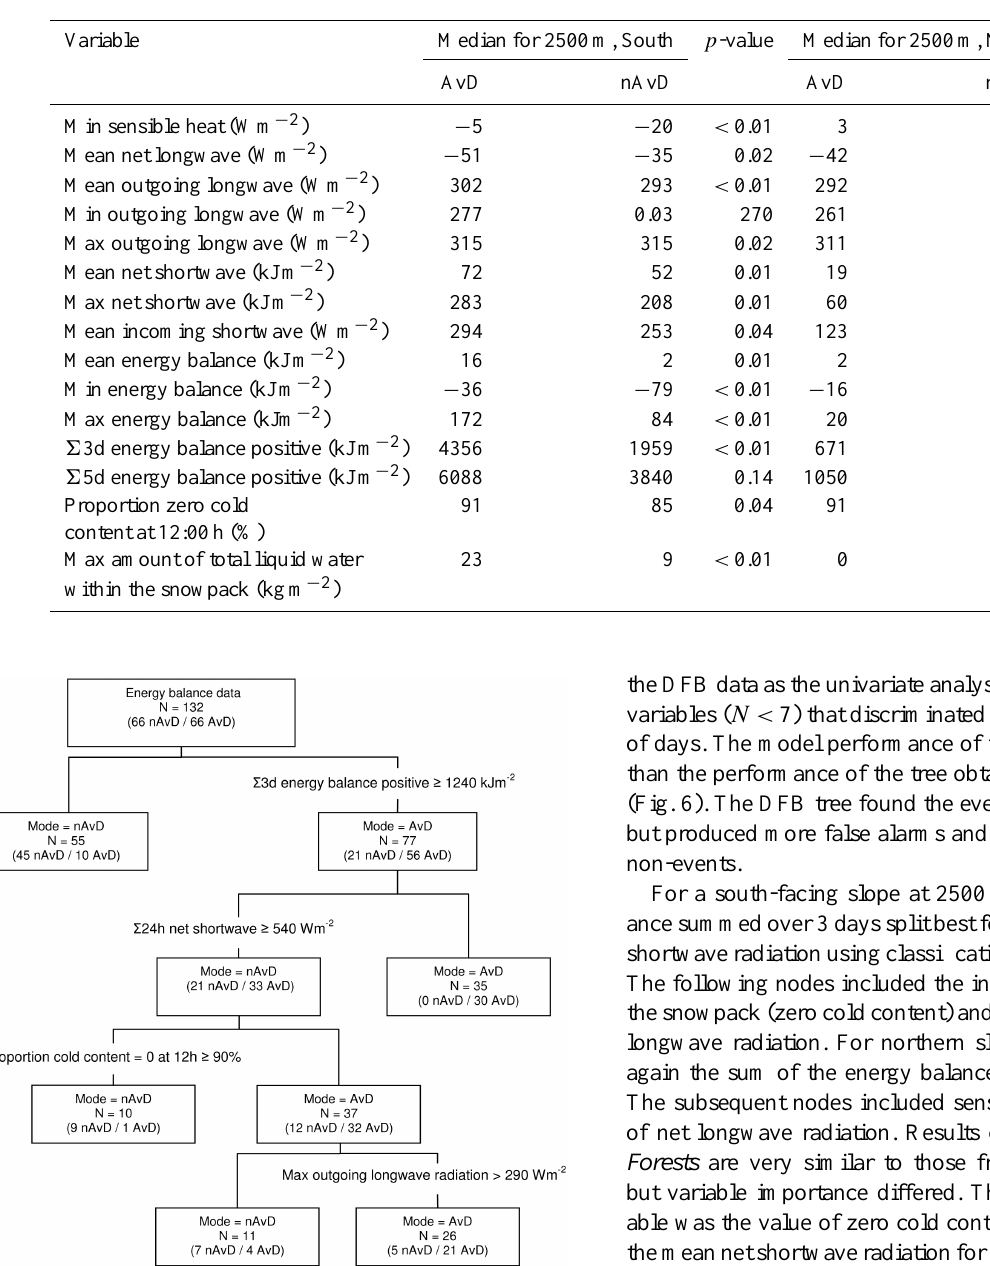
Table 4. Comparison of avalanche (AvD) to non-avalanche days (nAvD) for variables derived from the energy balance calculated for a 35 ◦ slope. For each variable, distributions from avalanche days and non-avalanche days are contrasted ( U -test), and the level of significance ( p -value) is given. Only variables with p < 0.05 are shown.